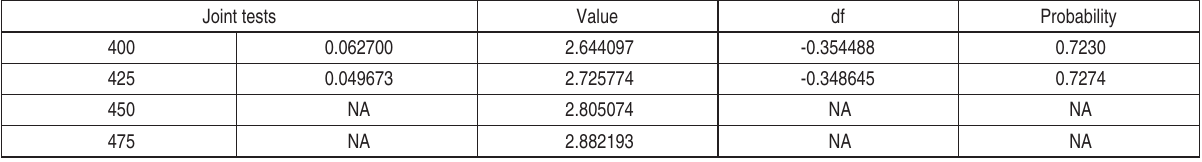
Table 6 (cont.). Results of the variance ratio test DSE ALSI weekly data